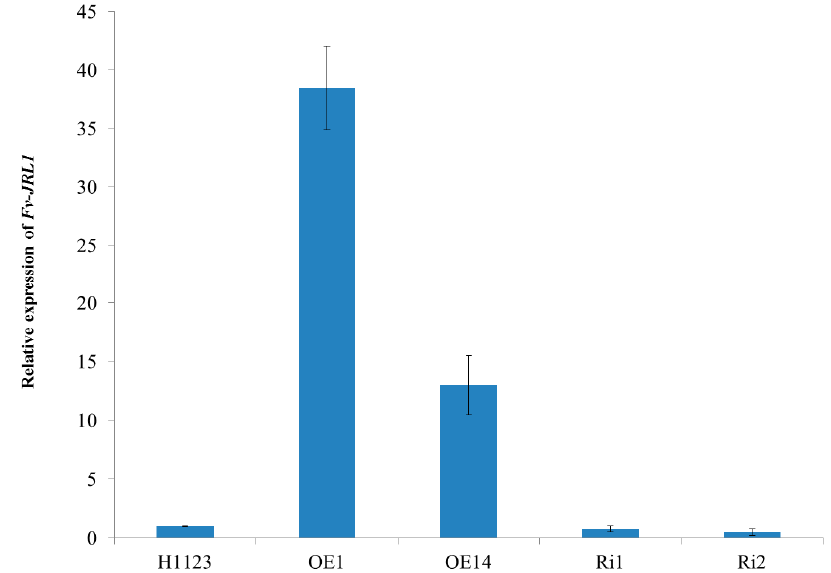
Figure 4. The transcription analysis of Fv-JRL1. The relative expression level of Fv-JRL1 was evaluated as fold changes in comparison with the expression level in the wild-type (WT) strain H1123.